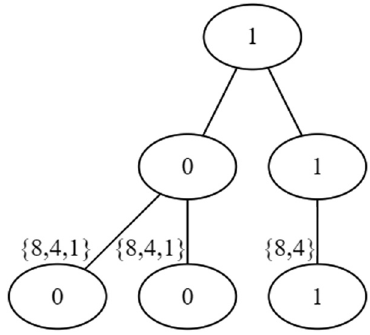
Figure 3: Tree directory for the Implementation of Step 2 ( ii ) , after assigning the two jobs of size